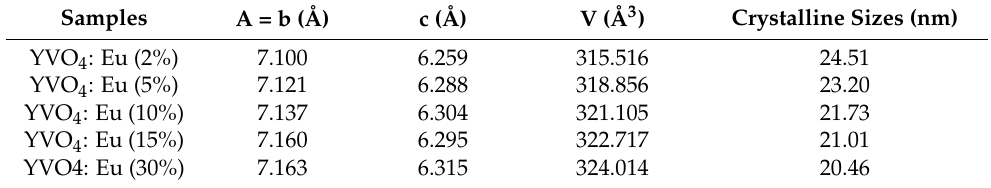
Figure 5. XRD patterns of the YVO 4 :Eu films with different molar doping concentration ( a ) and the schematic crystal structure of tetragonal REVO 4 ( b ). The Y 3+ ligands of YVO 4 crystal structure are shown in the insets. Table 1. The results of structure refinement and the crystalline sizes for YVO 4 :Eu 3+ .